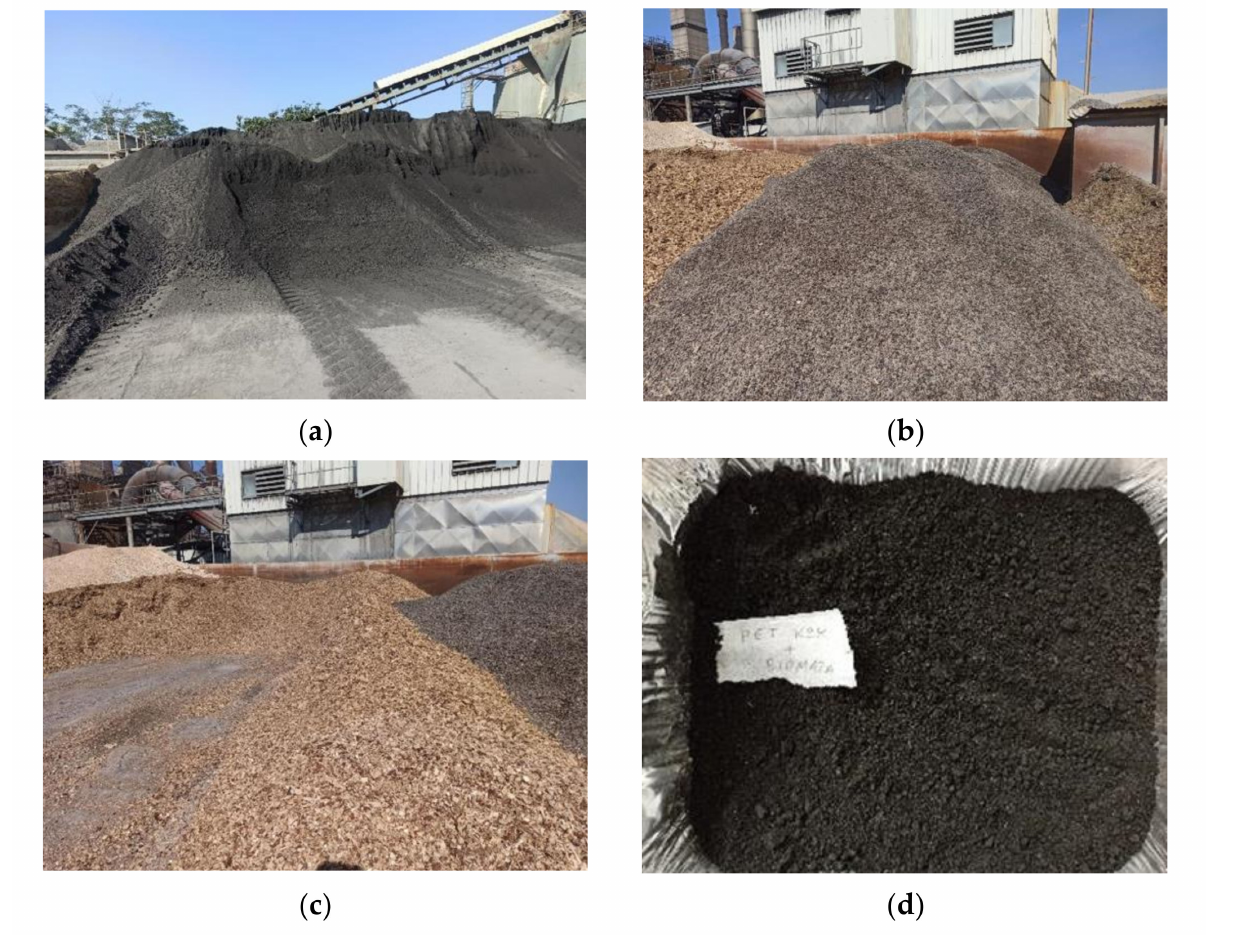
Figure 8. Pictures of fuels used during experimental campaign ( a ) pet coke, ( b ) sunflower husk pellets, ( c ) wood chips, and ( d ) sample of mixed fuel (sunflower husk pellets and pet